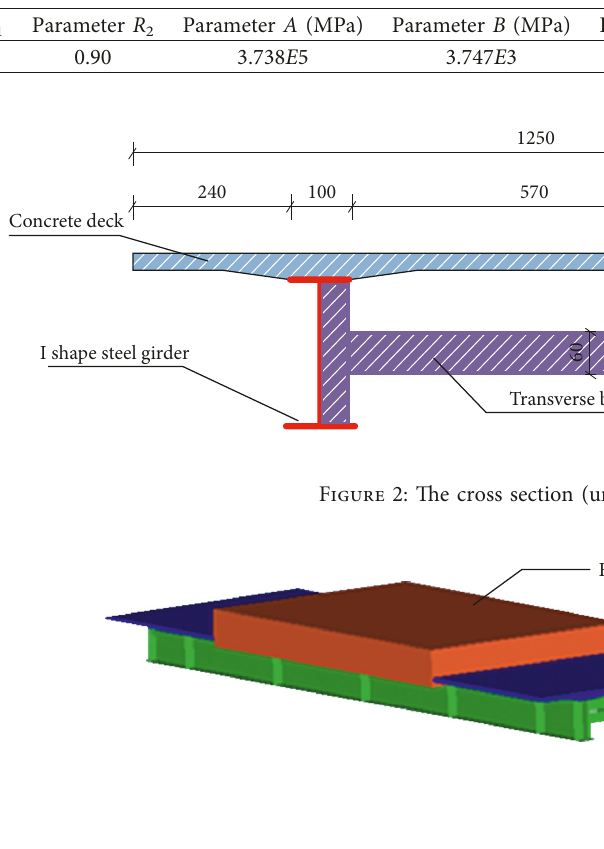
Figure 3: Analysis module in